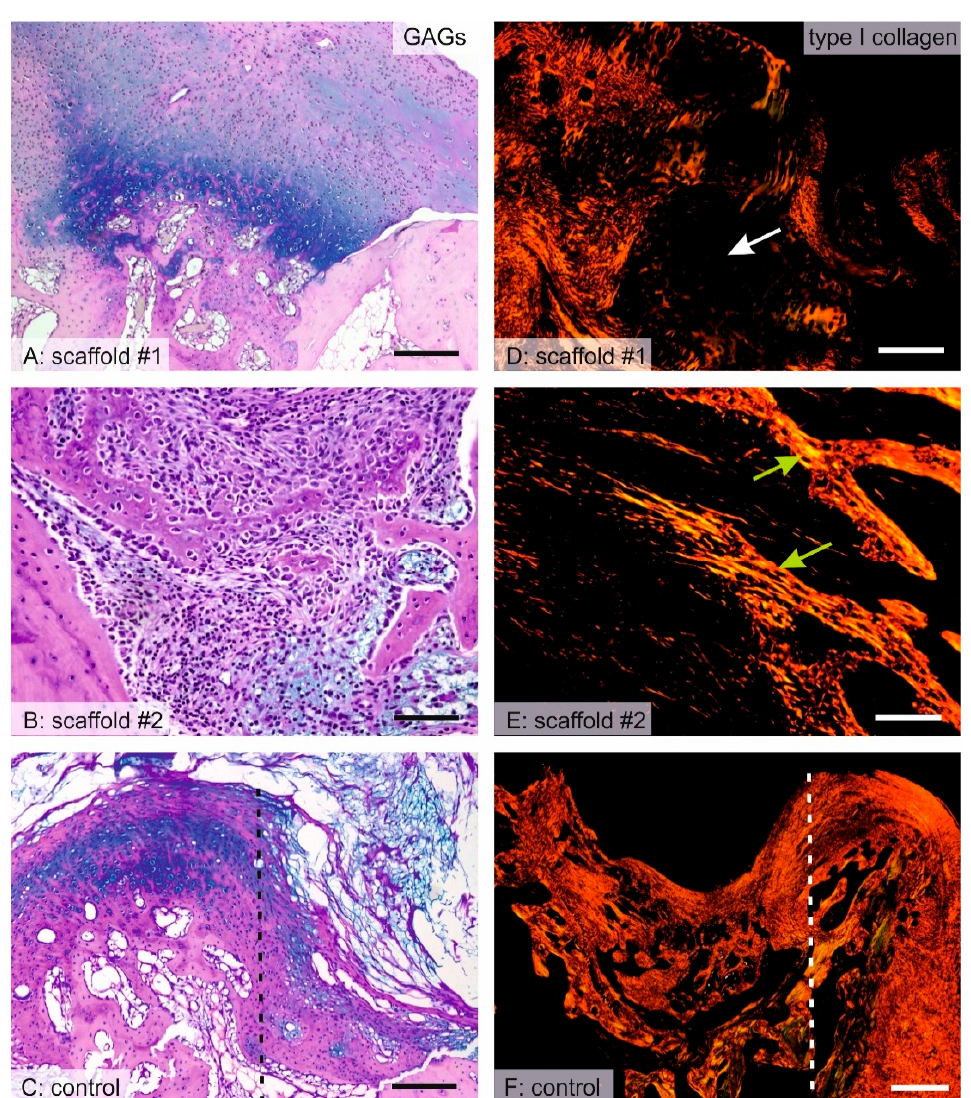
Figure 7. Comparison of the histology of healing with scaffold #1, scaffold #2, and without a scaffold. The microphotographs show either the central part of the defect ( A – C , E ) or the peripheral part of the defect ( C , F ). The border between the defect (C—right part of the image, F—left part of the image) and the original cartilage is marked by the dashed line. The alcian blue/PAS stain ( A – C ) demonstrated the glycosaminoglycans and the morphology of the samples. A—In samples with scaffold #1, a similar amount of hyaline cartilage was found when compared to the control samples ( C ). B—In samples with scaffold #2, desmogenous ossification was found on the bottom and on the sides of the defect. Picrosirius red ( D – F ) shows type I collagen fibers as red to yellow when observed in polarized light (right). D—Regions occupied by hyaline cartilage were negative for type I collagen and were dark (white arrow). E—The matrix of bone trabeculae found in the samples with scaffold #2 were positive for collagen I (green arrows). F—In control samples, large areas were filled by type I collagen-positive connective tissue. Scale bar: 200 µm ( A , D ); 100 µm ( B , C , E ); 500 µm ( F ).